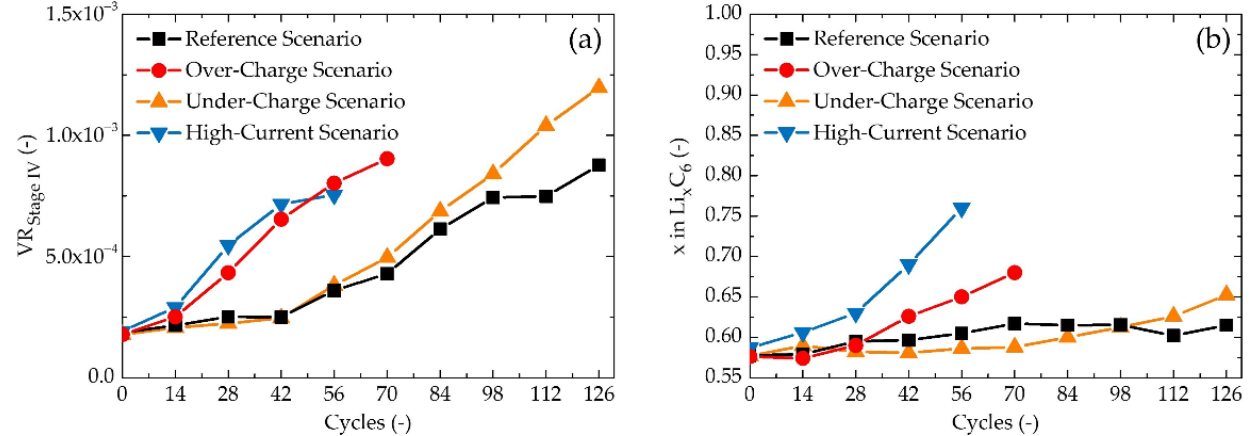
Figure 8. ( a ) Analysis of Li + diffusion for LiC 72 stage (valley A) via VR parameter ( b ) shift of peak E.